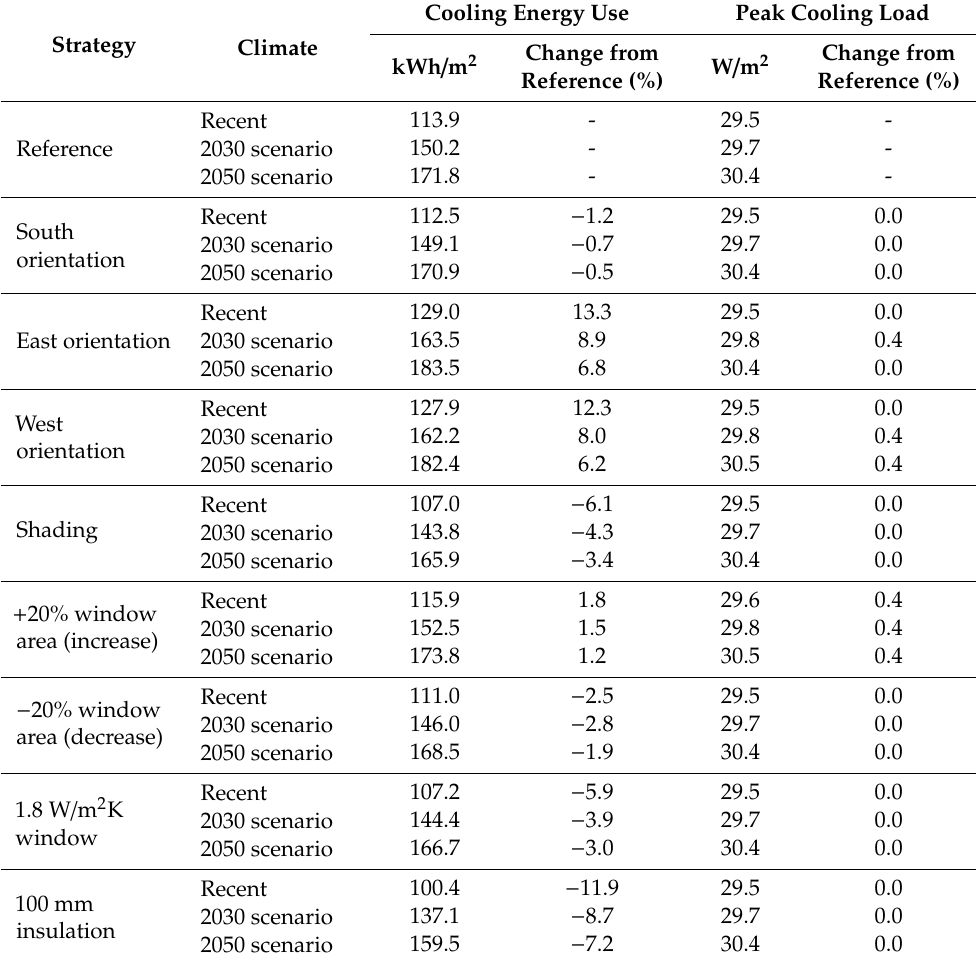
Table 7. Impacts of various strategies on final cooling energy demands and peak load of the building under di ff erent climate